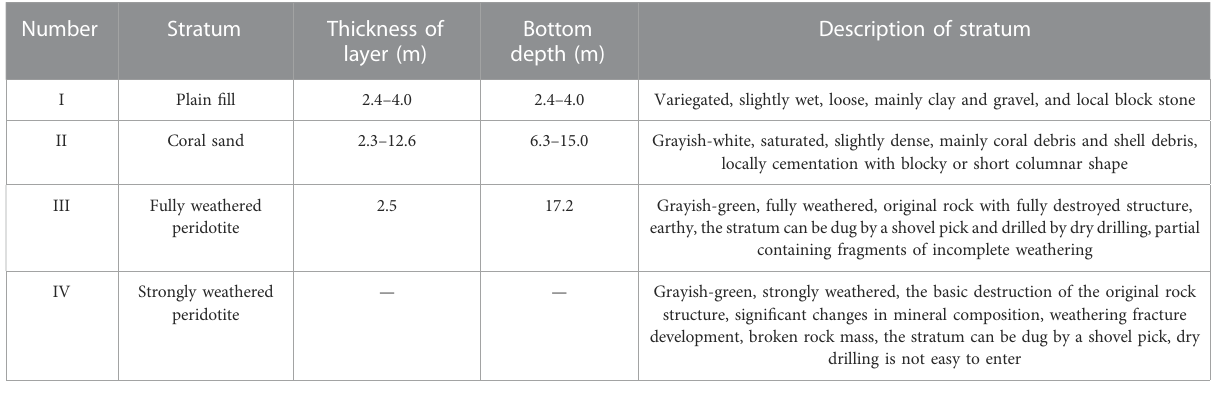
TABLE 3 Basic properties of the site strata.